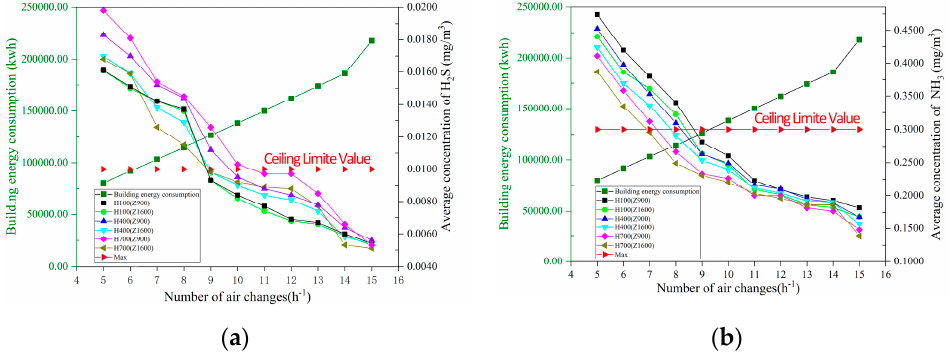
Figure 12. Relationship between energy consumption and the ACIPs. ( a ) Relationship between energy consumption and the average concentration of H 2 S; ( b ) Relationship between energy consumption and the average concentration of NH 3 ;